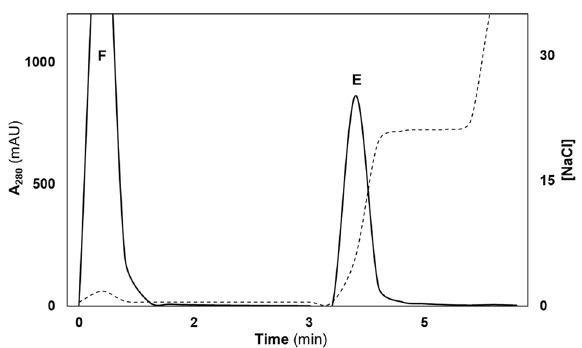
Fig. 1 A typical chromatogram of total IgG puri fi ed from serum on a CIM-histidyl disk. About 150 µL serum (tenfold dilution) in binding buffer, 25 mM MOPS buffer pH 6.5 was injected and the bound proteins were eluted with 25 mM MOPS pH 6.5 + 0.4 M NaCl. Flow rate: 4 mL/min. Peaks, F and E represent fl ow-through and elution, respectively.